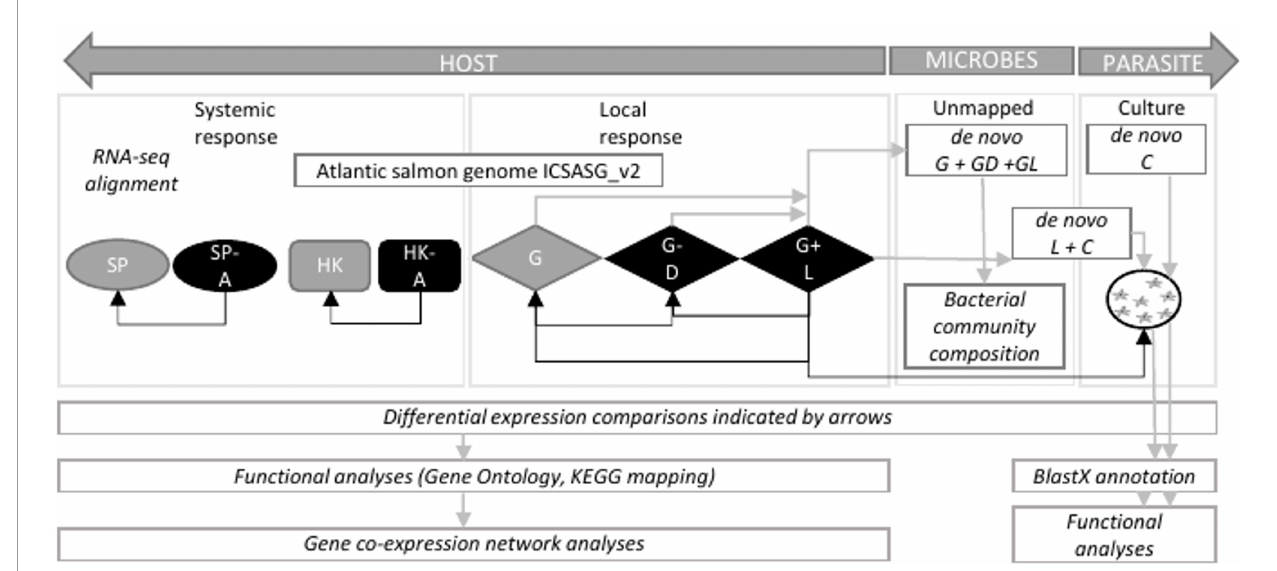
FIGURE 1 | Schematic showing datasets and analytical approach to infer host-parasite interaction in amoebic gill disease (AGD). HOST, Atlantic salmon ( Salmo salar ); PARASITE, Neoparamoeba perurans ; SP, spleen; A, AGD-affected; HK, head kidney; G, gill; D, distal to the lesion; L, lesion; C, cultured fl oating N. perurans